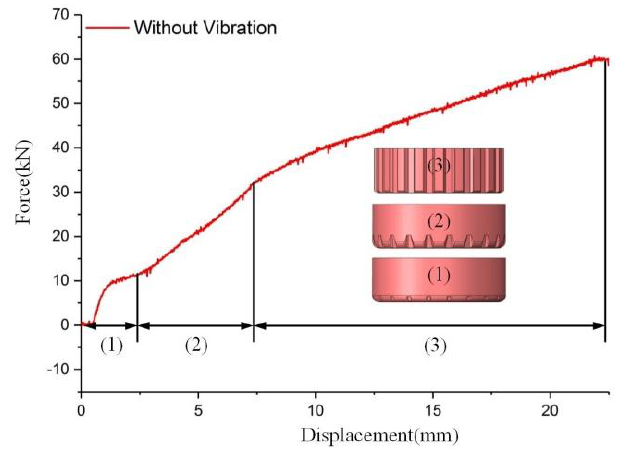
Figure 6. Load–displacement curve of clutch hub forming without vibration.